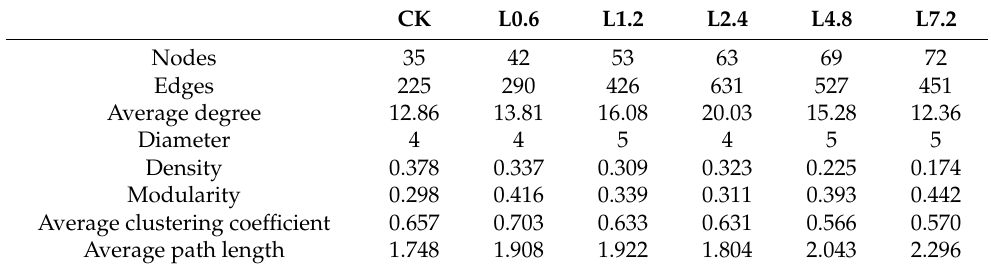
Table 3. Topological characteristic values of the bacterial community co-occurrence